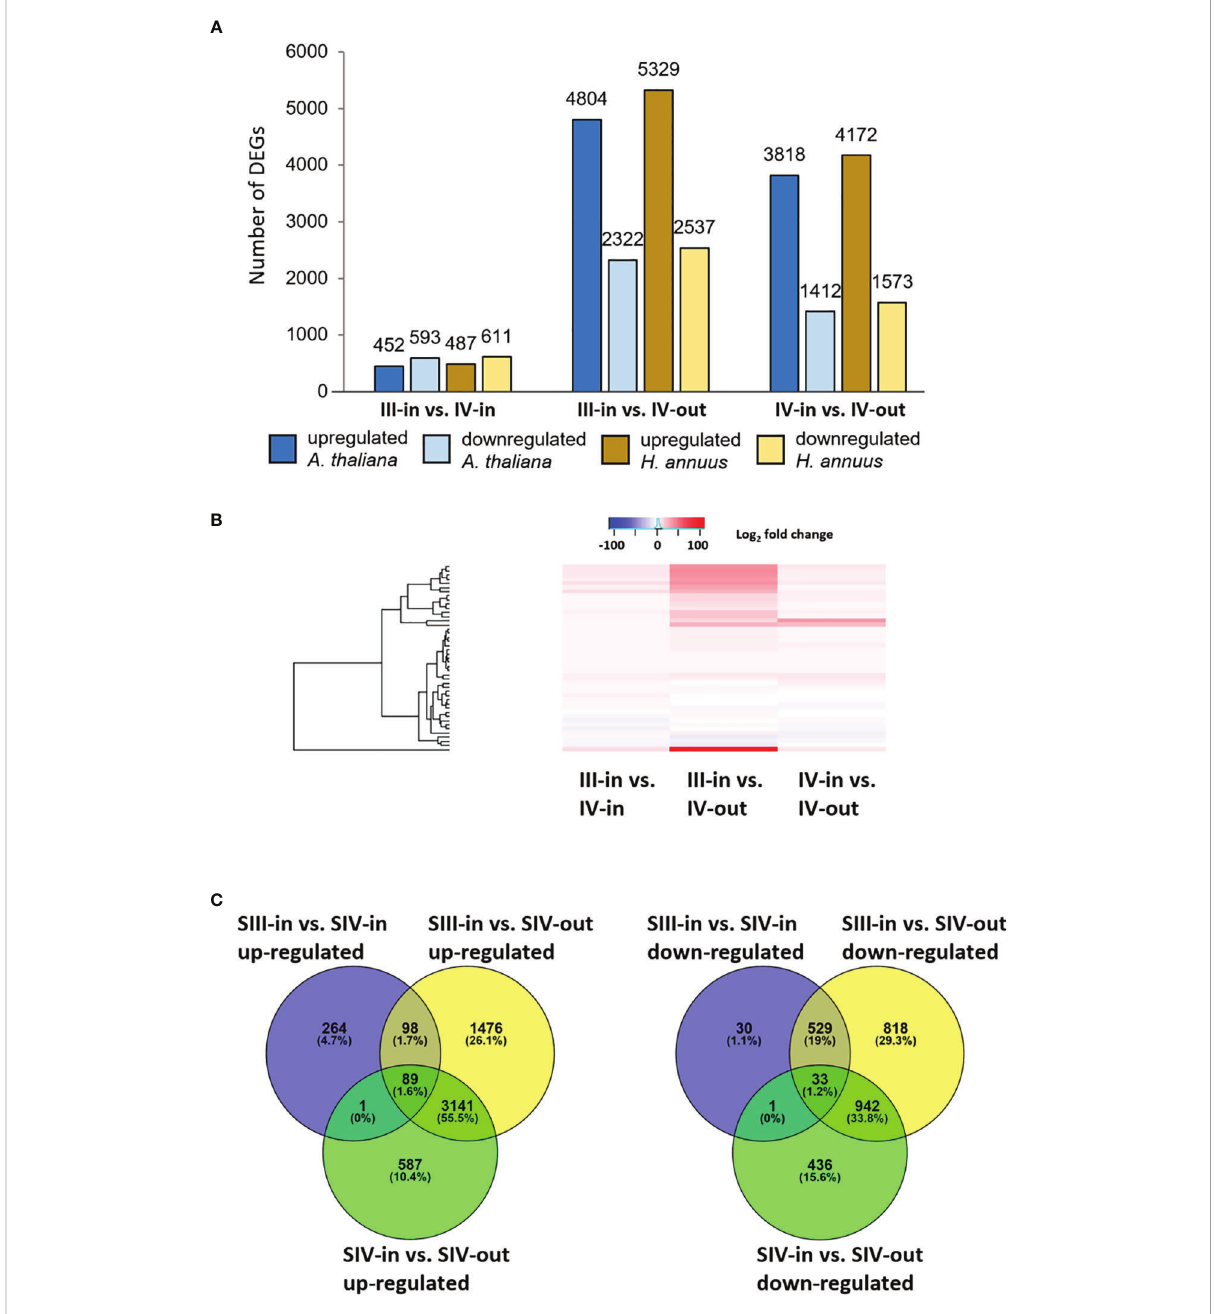
FIGURE 2 Transcriptomic analysis of dahlia fl orets (A) Number of DEGs homologous to A thaliana or H annuus proteins in each sample comparison; (B) heat map of up and downregulated genes, and present in all sample comparisons. Red to blue scale shows Log 0.05); (C) Venn diagrams of up- and down regulated genes, based on annotation to Arabidopsis thaliana ( p adjust. < 0.05) inner fl orets of Stage III fl owers (SIII-in), inner fl orets of Stage IV fl owers (SIV-i) and outer fl orets of Stage IV fl owers